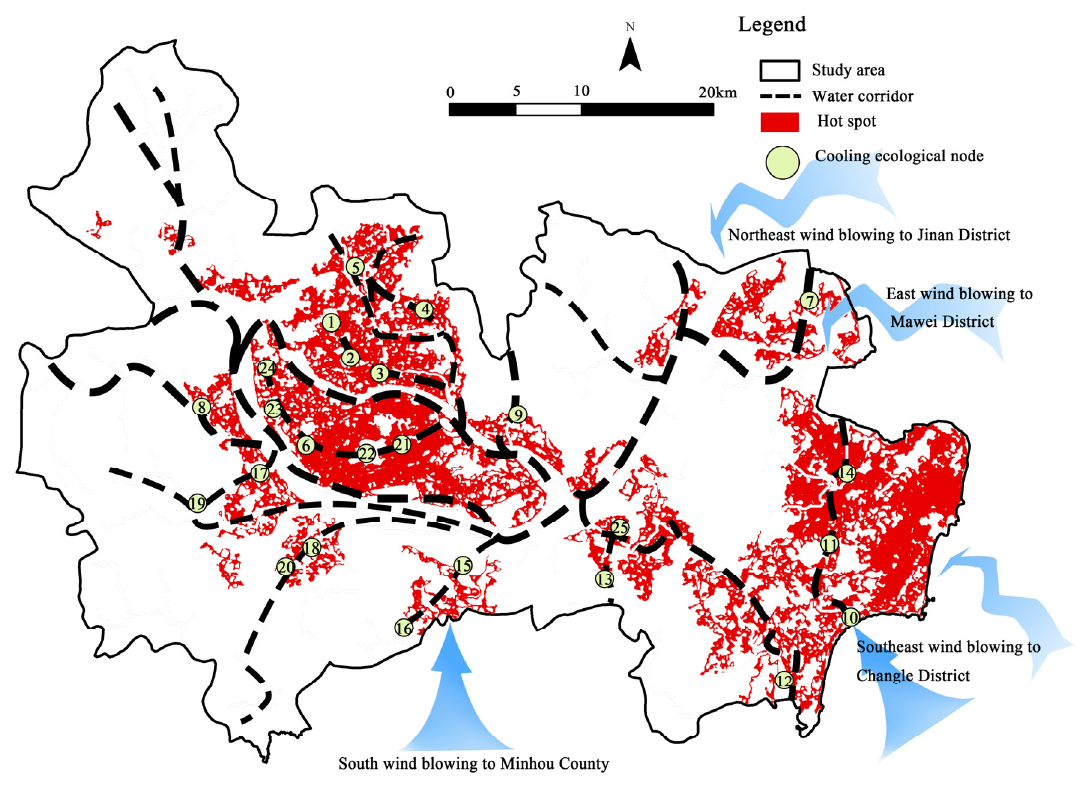
Figure 11. Cooling water corridor in Fuzhou, China.